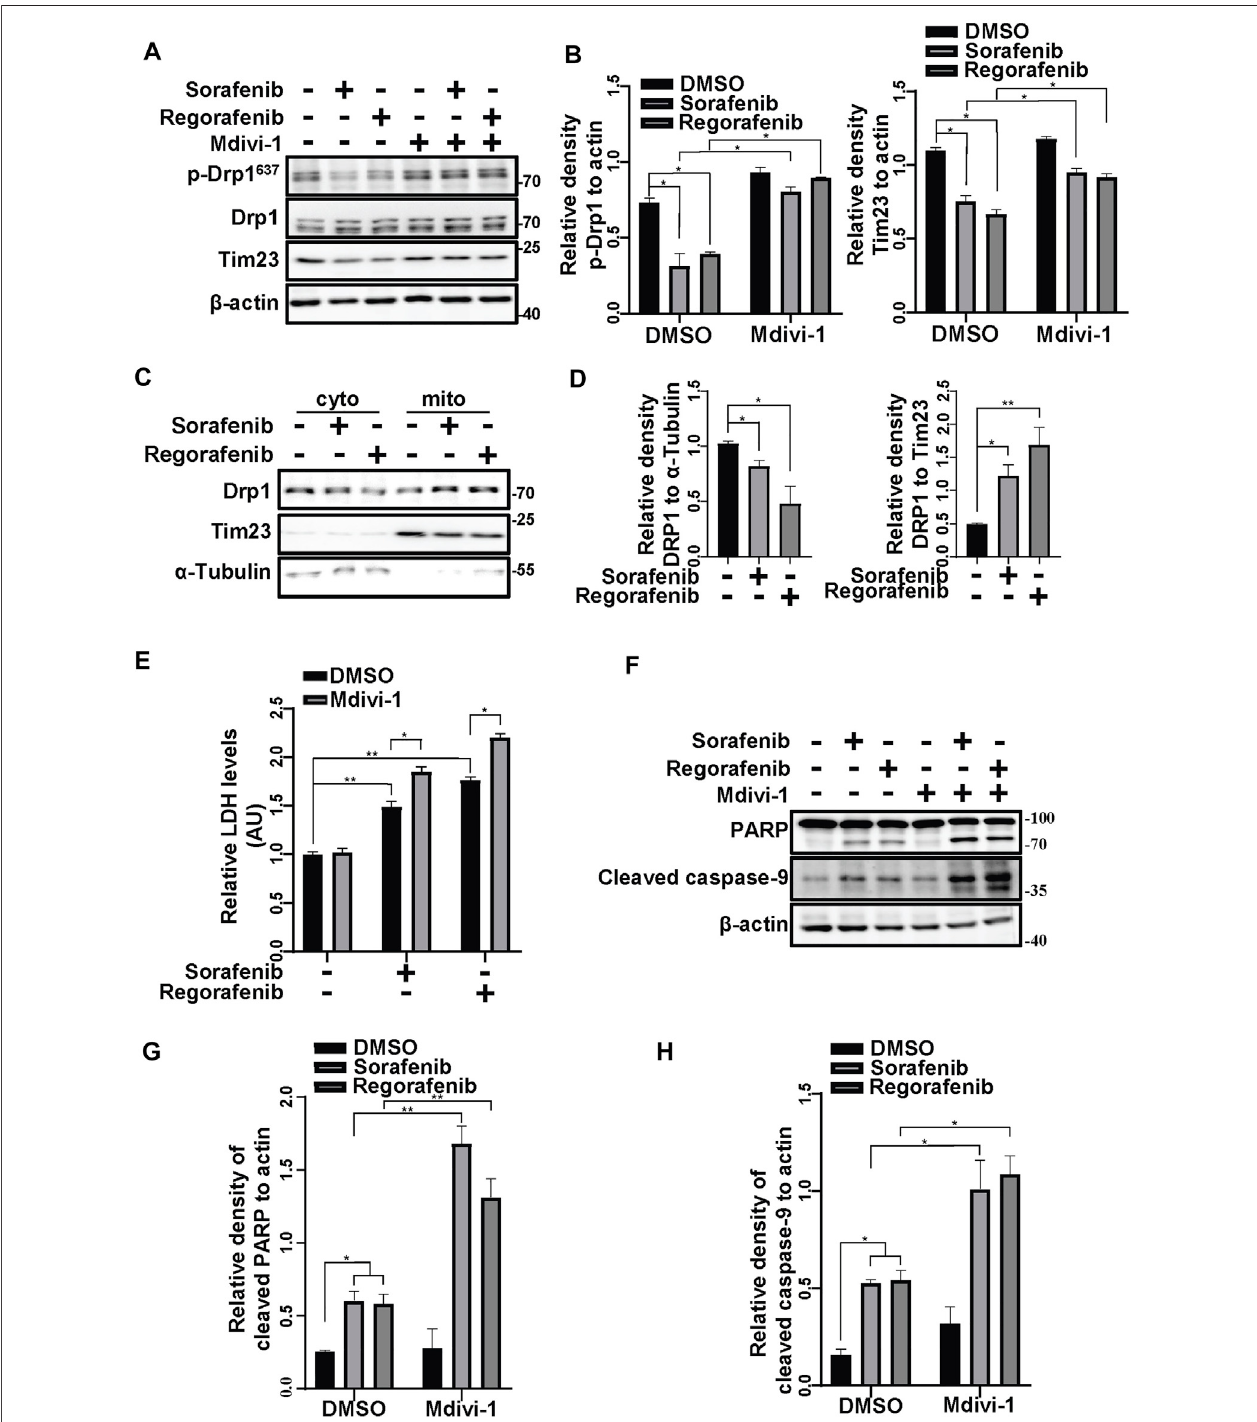
FIGURE5| Inhibitingmitochondrial fi ssionincreasesthecelldeathinducedbysorafenibandregorafenib. (A) HepG2cellsthatwerepretreatedwithMdivi-1(10 μ M) for 1 h and treated with sorafenib (20 μ M) or regorafenib (30 μ M) for 4 h were subjected to western blotting. p-Drp1, Drp1, and Tim23 were labeled with the indicated antibodies. (B) The relative densities of p-Drp1 and Tim23 were quanti fi ed, and the protein levels were normalized to the loading control ( β -actin). Values are the mean ± SEM from three independent experiments (* p < 0.05, two-way ANOVA and Tukey ’ s multiple comparisons test). (C) HepG2 cells were treated with sorafenib (20 μ M) or regorafenib (30 μ M), and the mitochondrial and cytosolic fractions were separated using a mitochondria isolation kit. Drp1 protein levels in the cytosol or mitochondria were detected with immunoblot analysis. (D) The relative density of Drp1 was quanti fi ed, with the protein level normalized to the loading control